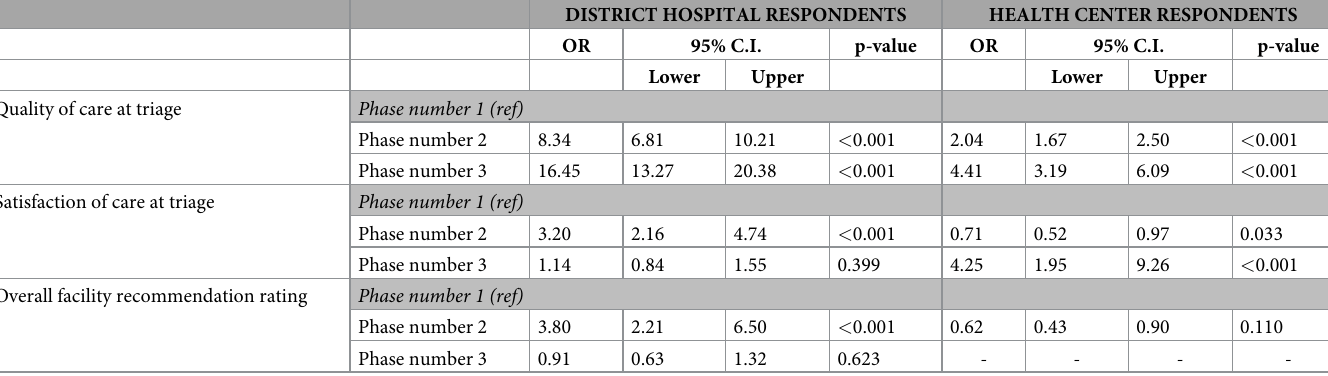
Table 4. Logistic regression of women’s perceptions of care controlled for sampling weights and covariates.